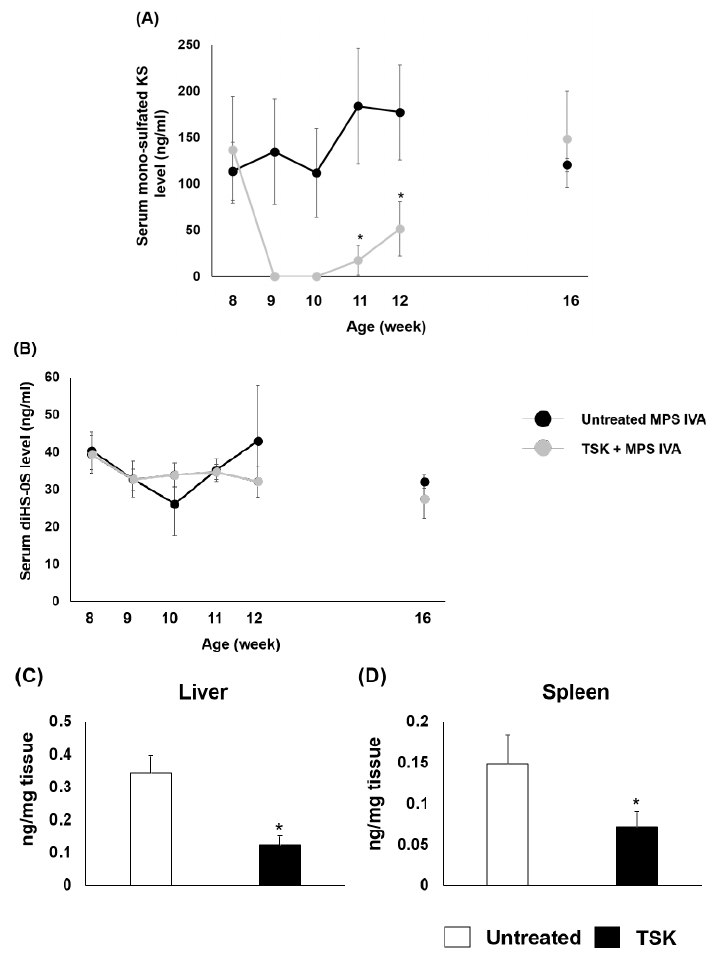
Figure 2. Serum and tissue glycosaminoglycan levels of MPS IVA mice after a single administration